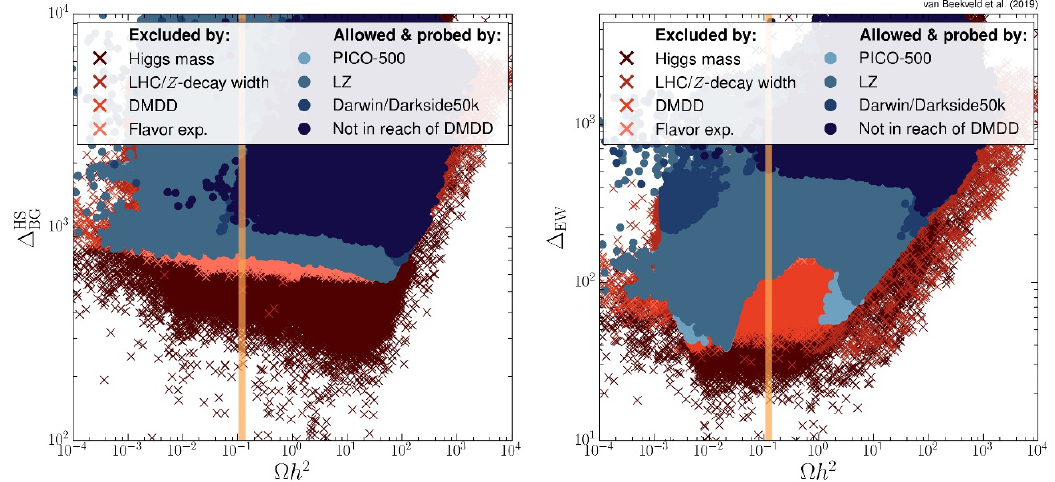
Figure 1 . Generated spectra for the mSUGRA model. The left (cid:12)gure shows (cid:1) HS of (cid:10) h 2 , the right (cid:12)gure shows (cid:1) EW as a function of (cid:10) h 2 . Red crosses indicate that the spectrum is excluded due to (in plotting order): the Higgs mass requirement (darkest red); limits placed on SUSY masses; by DMDD experiments; by limits placed on several (cid:13)avor physics observables (lightest red) respectively. The constraints are also checked in this order. Circles in di(cid:11)erent shades of blue indicate the sensitivity of DMDD experiments, where in order of decreasing brightness we indicate: PICO-500, LZ, Darwin/Darkside50k or unconstrained by DMDD experiments. Uncon- strained spectra lie on top of more constrained and excluded spectra. The exclusions checks are only performed once in the indicated order, The orange band indicates (cid:10) h 2 = 0 : 12.